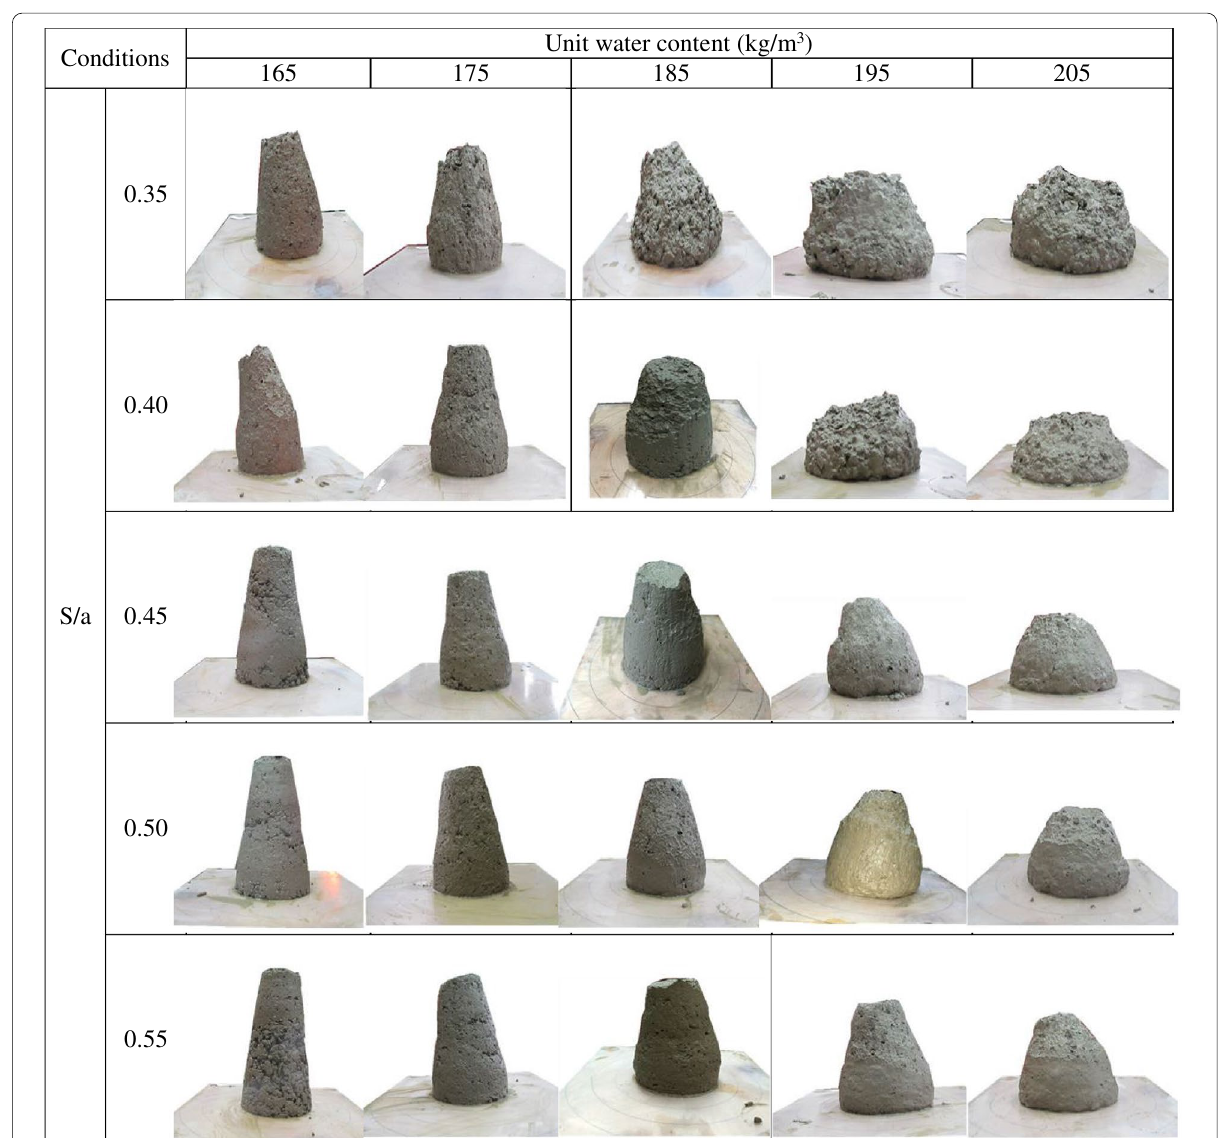
Fig. 12 Shapes of the slumping concrete after slump test for high‑strength concrete